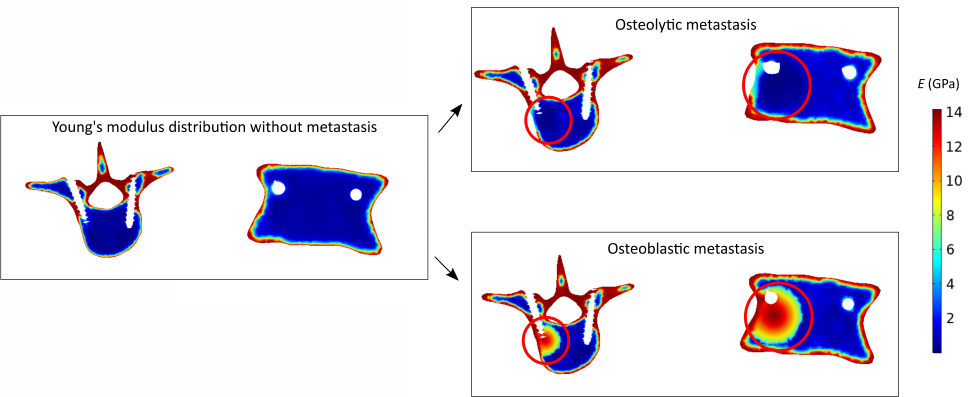
Figure 3. The local effect induced by osteolytic and osteoblastic metastasis on bone material properties is shown. On the left, Young’s modulus E distribution without metastasis is reported. On the right, the effects of osteolytic and osteoblastic lesions are circled in red. In the case of an osteolytic lesion, a local weakening is produced, whereas an osteoblastic metastasis induces a local